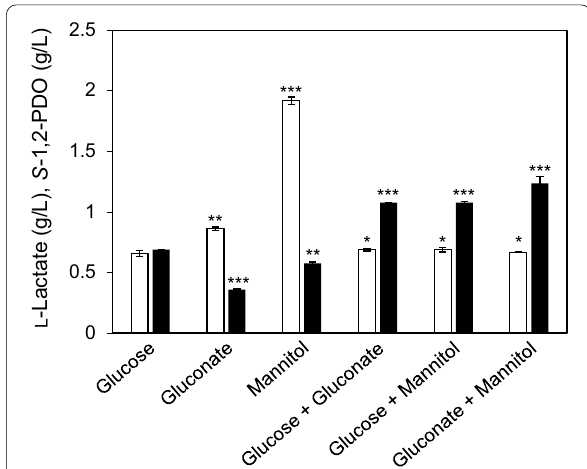
Fig. 3 Characterization of S -1,2-PDO and L-lactate production in the resting cells of L. lactis LL1 incubated with 1% glucose, 1% mannitol, and/or 1% gluconate. The resting cells of L. lactis LL1 were incubated for 72 h at 30 °C in 100 mM phosphate buffer containing 1% glucose, 1% mannitol, and/or 1% gluconate. White bars, L-lactate; black bars, S -1,2-PDO. This experiment was performed in duplicate, and the average is represented with error bars. * P > 0.05, **0.01 < P < 0.05, *** P < 0.01 vs addition of only 1% glucose